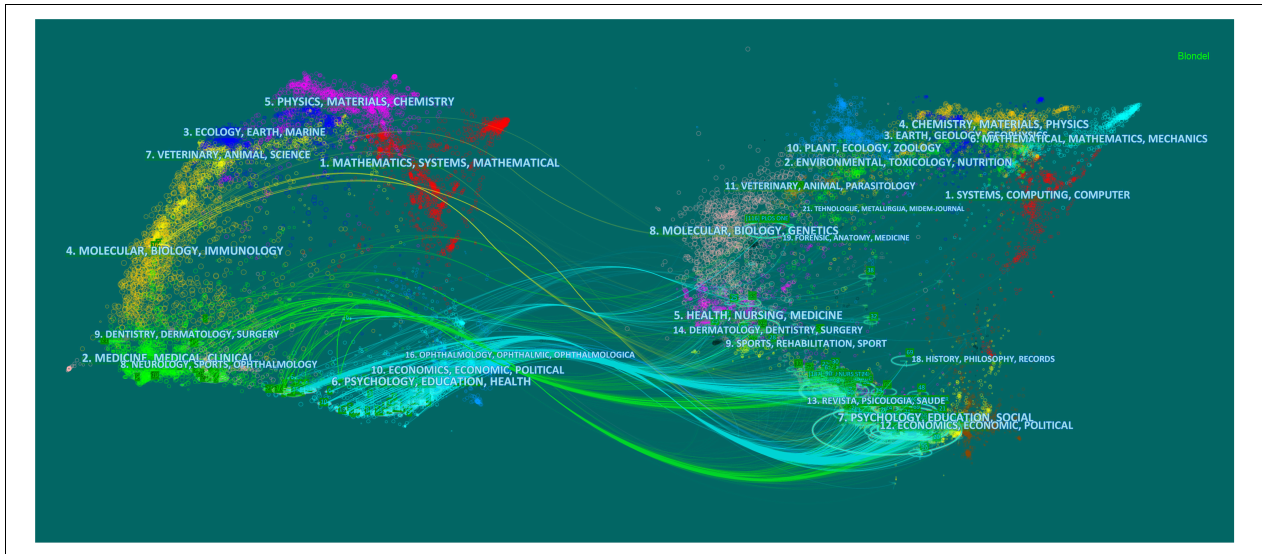
FIGURE 3 | The dual-map overlay of journals. Citing journals are on the left and cited journals are on the right, and the colored paths between them suggested the cited relationships.